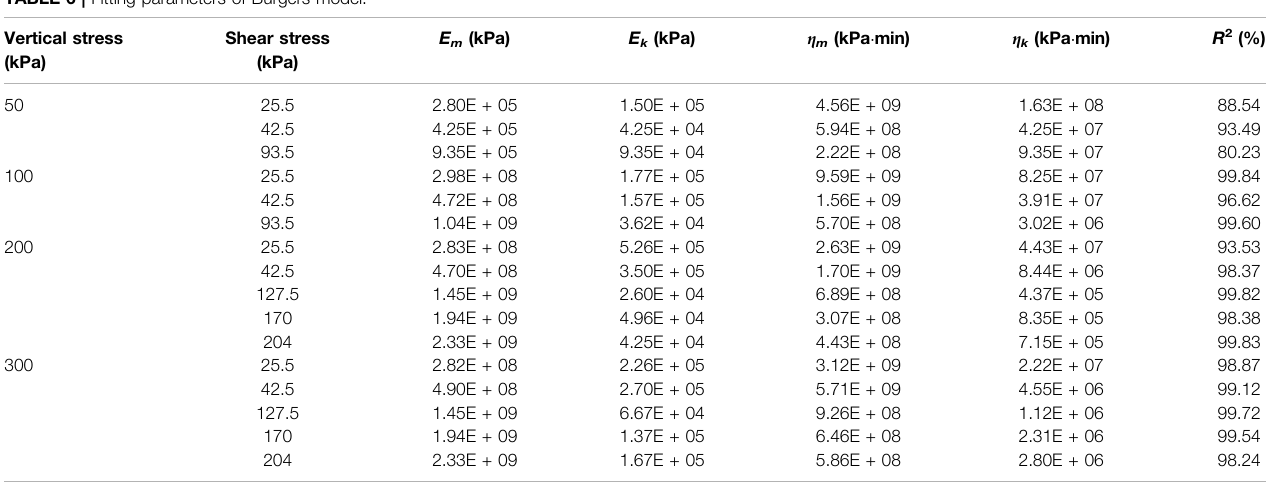
TABLE 6 | Fitting parameters of Burgers